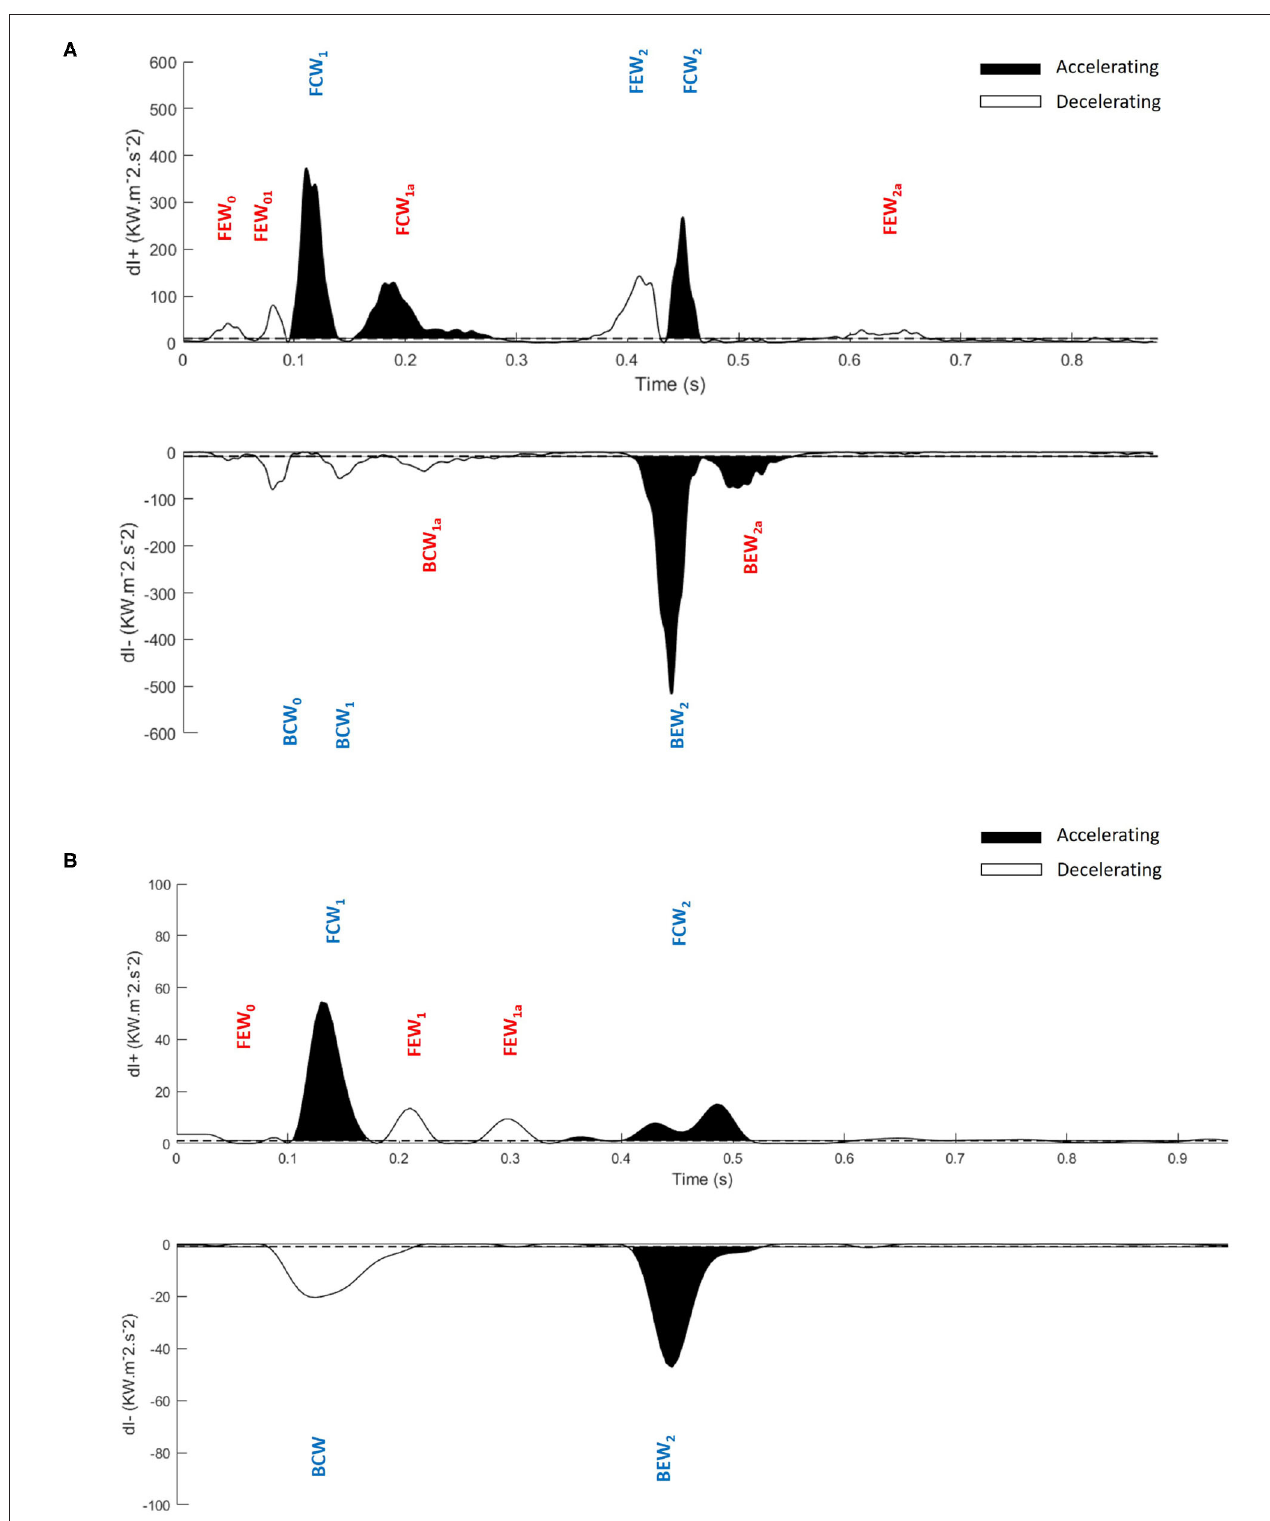
FIGURE 5 | Application of the maximum entropy method to wave intensity waveforms and identification of significant peaks. Significant peaks in the separated ensemble average wave intensity waveforms; forward ( dI + ) and backward ( dI − ), (A) Control subject, (B) Hypertrophic Obstructive Cardiomyopathy patient. FEW, Forward Expansion Wave; FCW, Forward Compression Wave; BCW, Backward Compression Wave; BEW, Backward Expansion Wave. The blue colored waves are the dominant waves, and red colored waves are the secondary waves. Note the difference in scales between (A,B) .